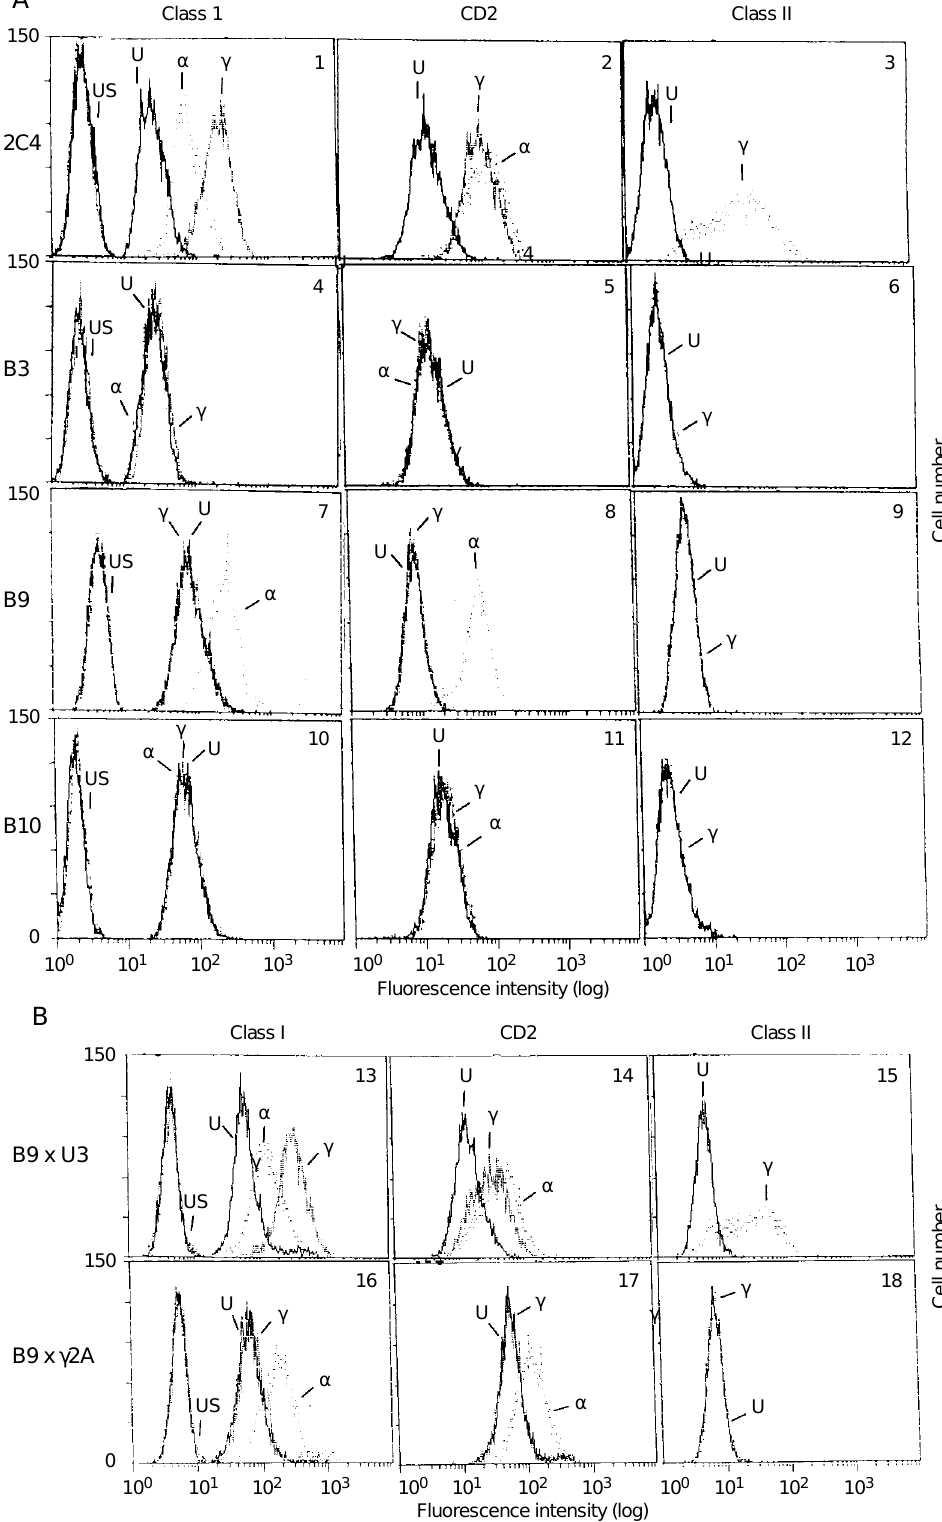
Figure 1 - FACS analysis of the parental and mutant cell lines. A , 2C4, B3, B9 and B10; B , genetic crosses B9 x U3 and B9 x g 2A; C , pairwise crosses between B3 x U3 and B3 x U4. The expres- sion of the cell surface markers CD2 (panels 2,5,8,11,14,17,20, 23) and endogenous class I (pan- els 1,4,7,10,13,16,19,22) and II HLAs (panels 3,6,9,12,15,18,21, 24) upon IFN- a or IFN- g stimula- tion (500 IU/ml for 48 h) was monitored by FACS analysis as described in Material and Meth- ods. Panels 1-3: Parental cell line 2C4; panels 4-6: mutant B3; pan- els 7-9: mutant B9; panels 10- 12: mutant B10; panels 13-15: genetic cross between B9 and the U3 mutant; panels 16-18: genetic cross between B9 and the g 2A mutant; panels 19-21: pairwise crosses between mu- tants B3 and U3; panels 22-24: pairwise crosses between mu- tants B3 and U4. Untreated cells (U), IFN- a ( a )- or IFN- g ( g )-treated cells, and unstained cells (US) as indicated. US cells were left un- treated or treated with IFN- a , but were not incubated with any an-